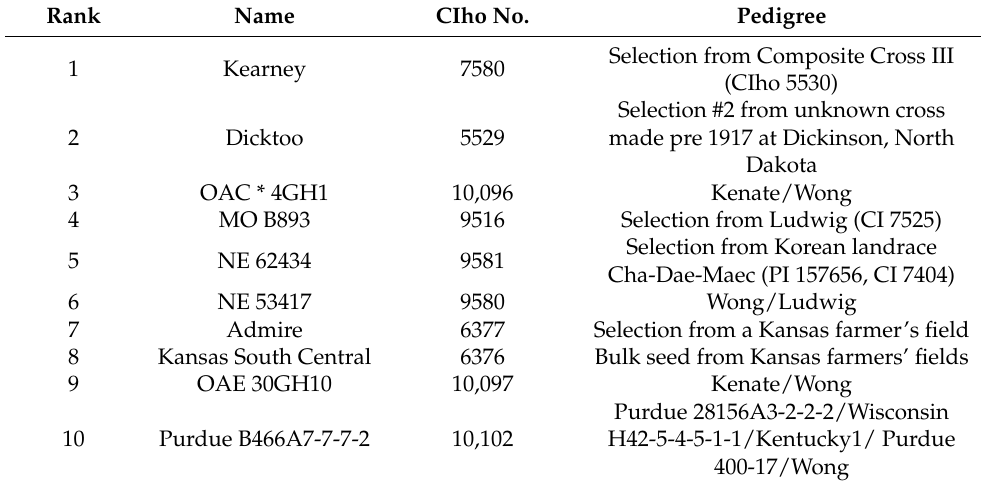
Table 1. Top 10 winter-hardy lines of 204 tested at 111 sites across North America